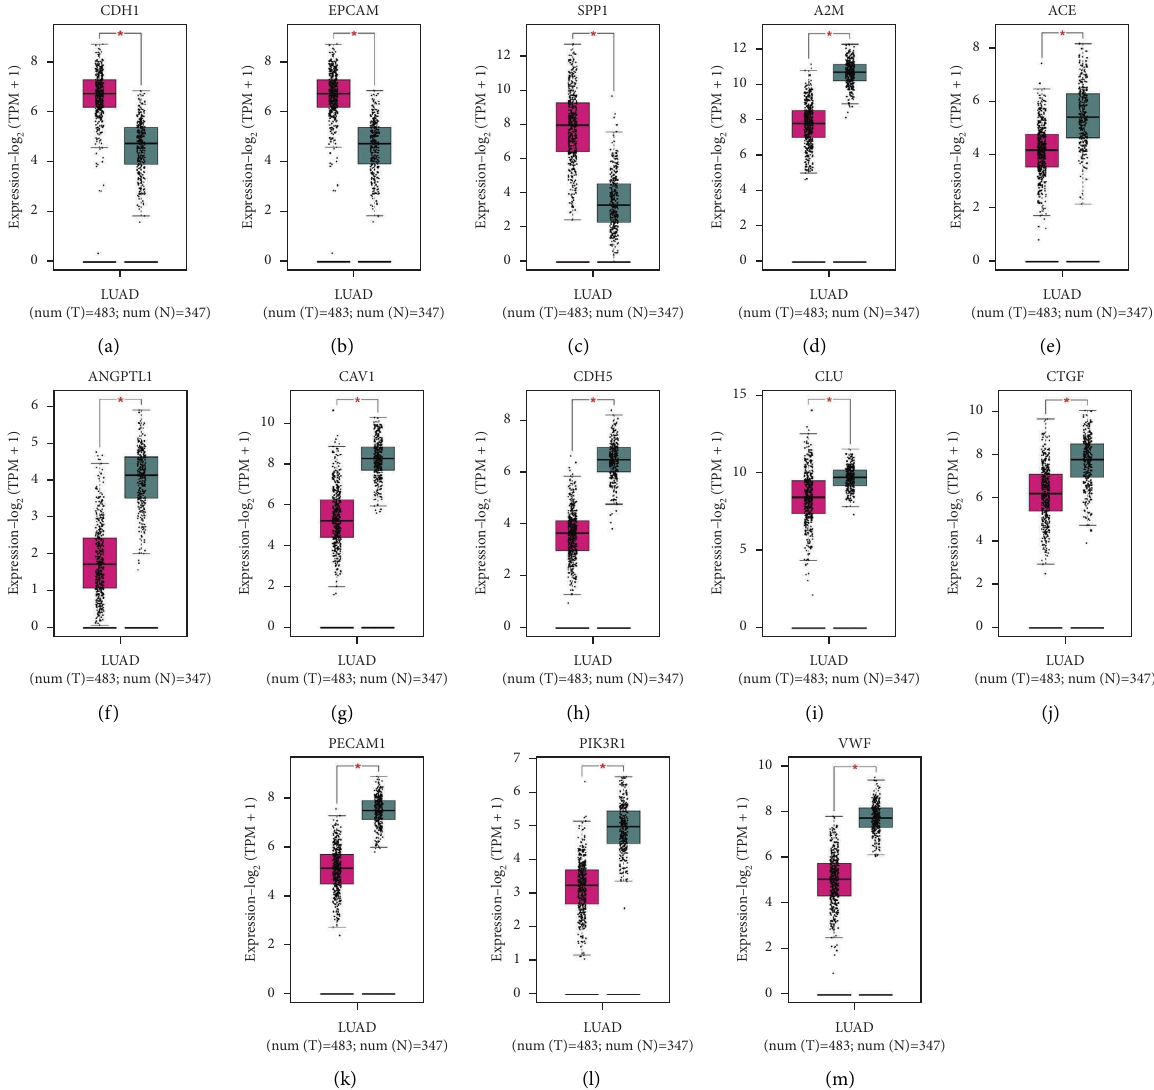
Figure 6: Expression analysis of 13 hub genes in lung adenocarcinoma based on GEPIA. (a) CDH1, (b) EPCAM, (c) SPP1, (d) A2M, (e) ACE, (f) ANGPTL1, (g) CAV1, (h) CDH5, (i) CLU, (j) CTGF, (k) PECAM1, (l) PIK3R1, and (m) VWF; P < 0 . 05 was considered as statistically